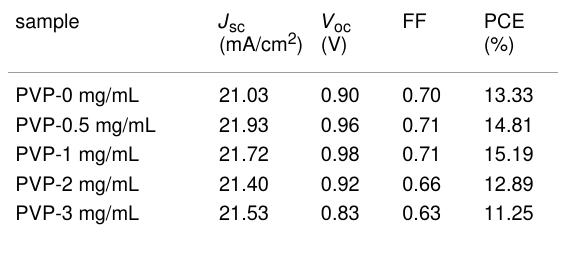
Table 1: Parameters of the PSCs fabricated under different